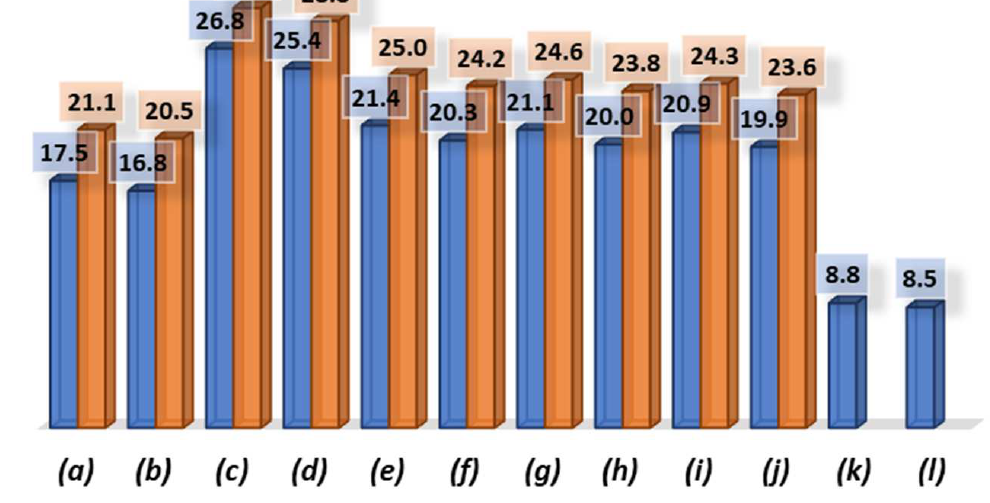
Figure 6. Percentage of RES in TFC (%).